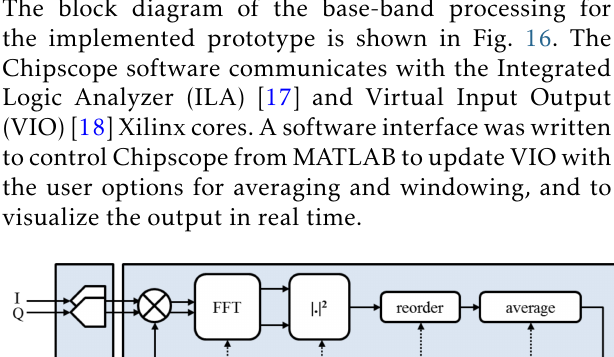
Table 2. Design FPGA resource utilization (map results)